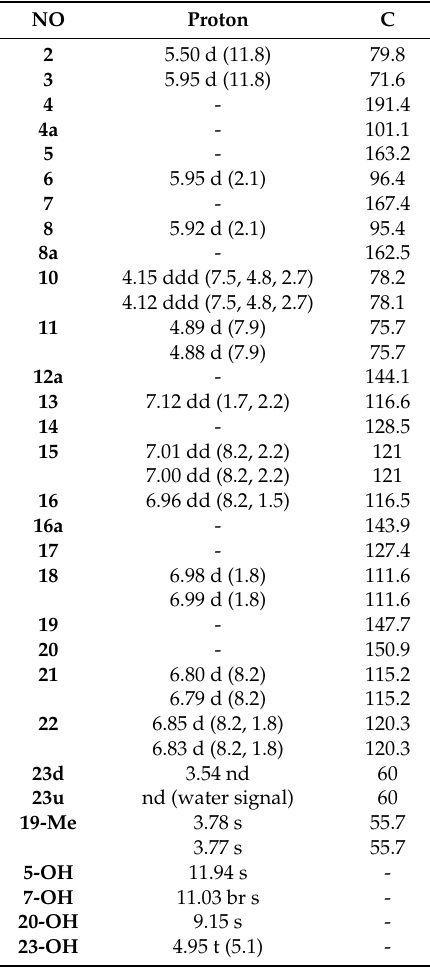
Table 1. 1 H NMR spectral data of 2